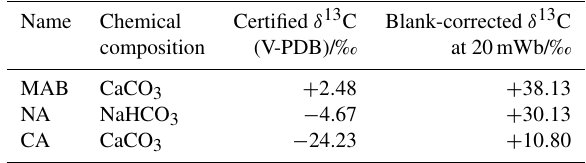
Table 1. The SUERC-ICSF calibration